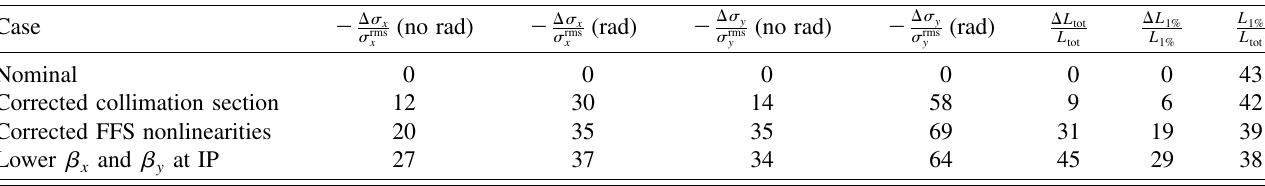
TABLE I. CLIC luminosities for the different optimizations stages. All numbers are in percent units.